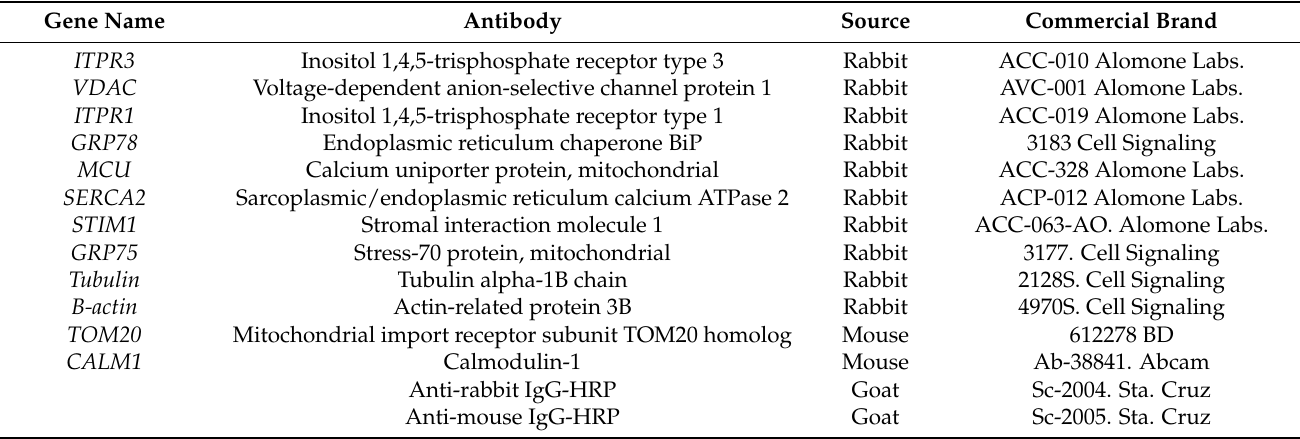
Table A3. Ca 2+ transporters localized in